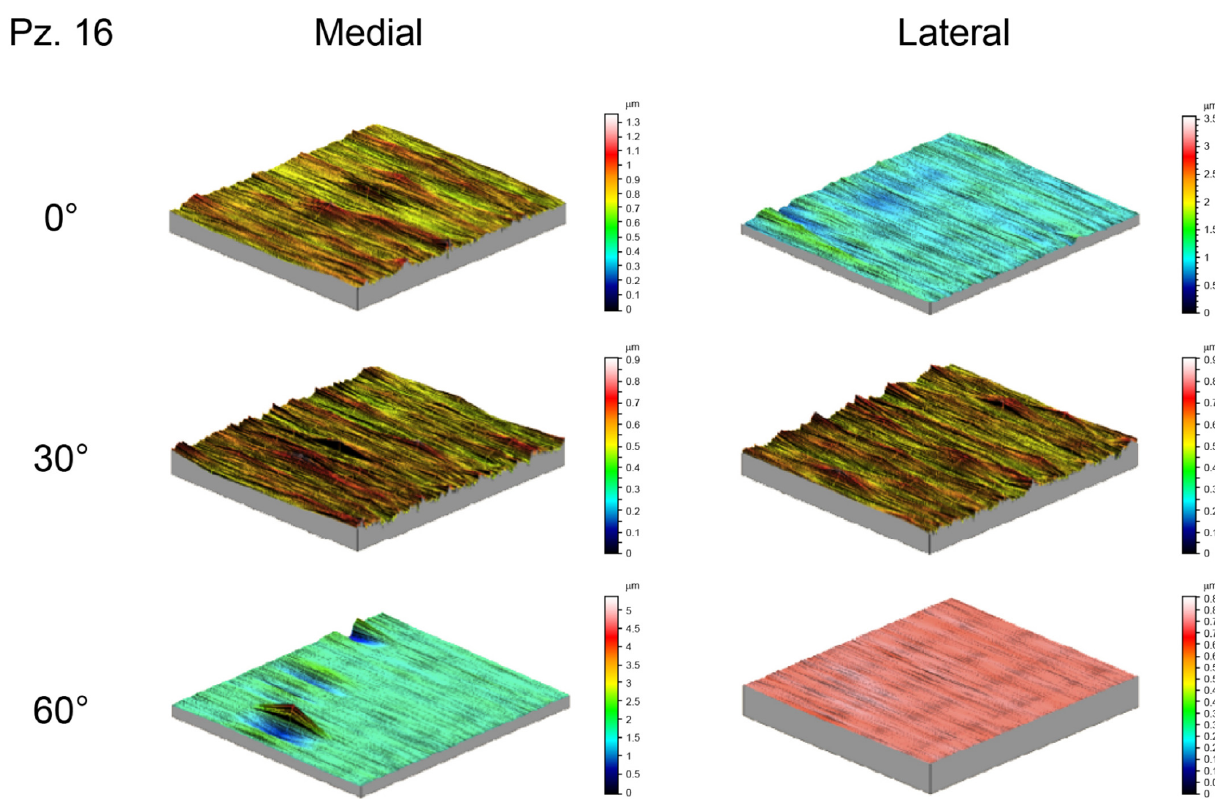
Figure 3. Topographical picture of the medial and lateral condyle with the medium Ra value.